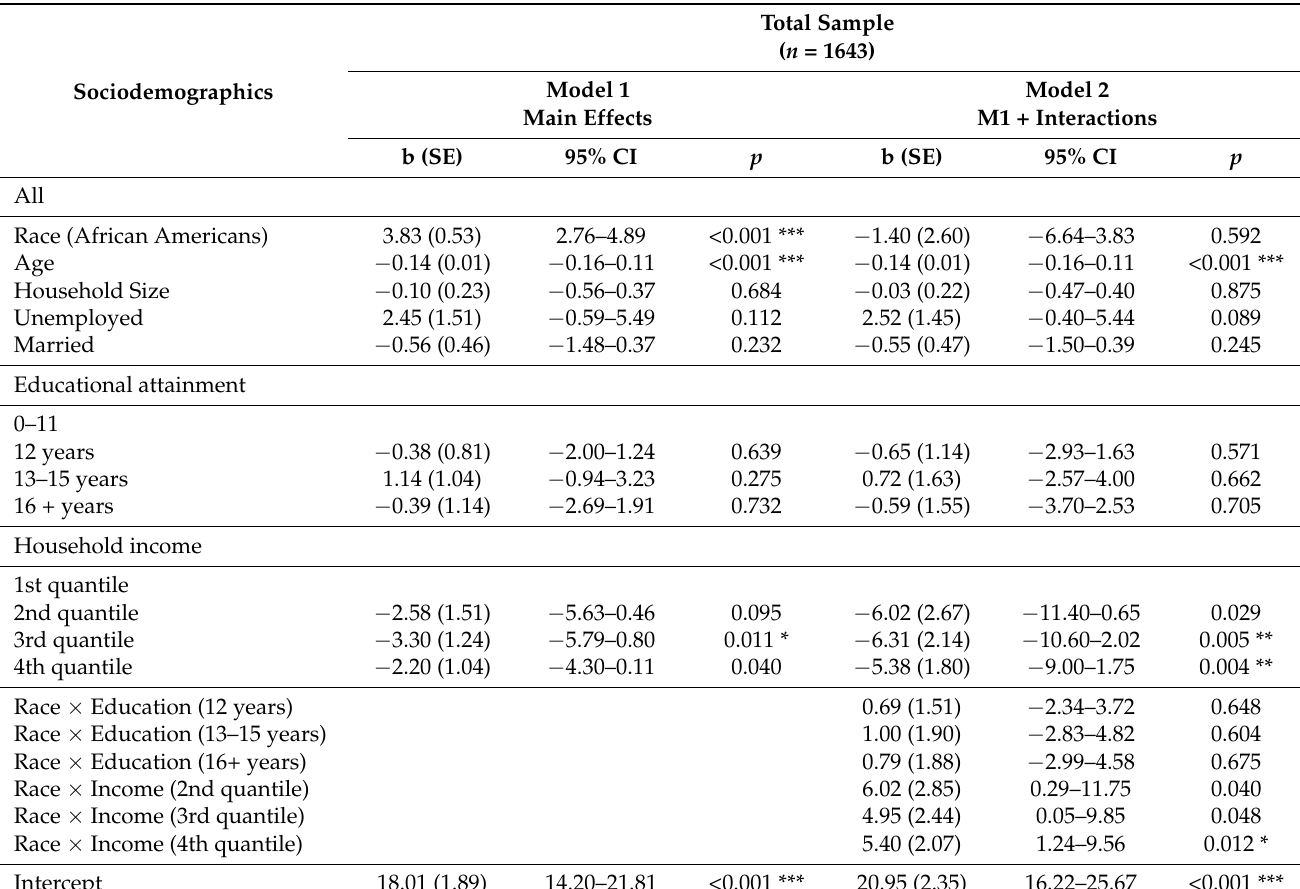
Table 2. Summary of linear regression on the effects of educational attainment and household income on perceived discrim- ination in the pooled sample of African American and Non-Hispanic White men in the National Survey of American